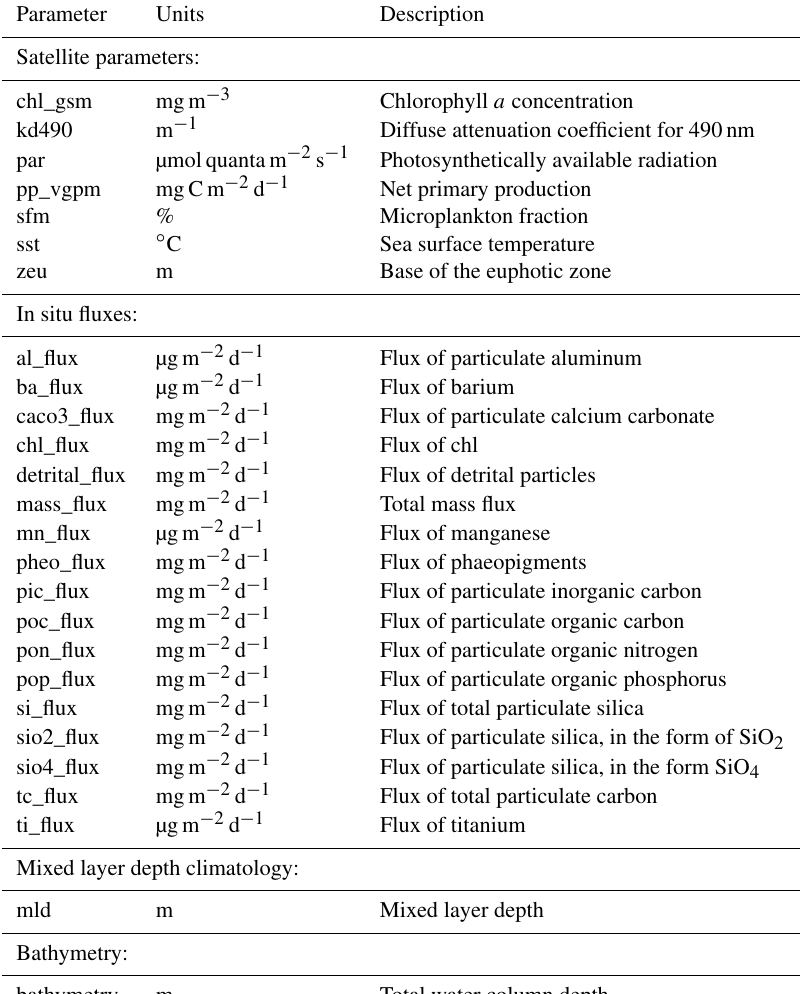
Table 1. Summary of data set parameters.